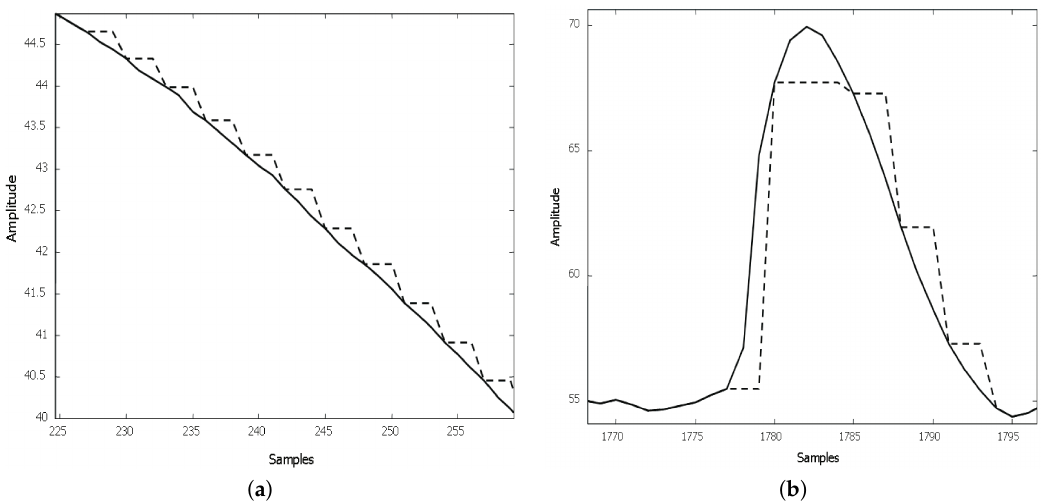
Figure 11. Problems for the wavelet approach. ( a ) case of too long sampling time with respect to the dynamics of the system; ( b ) signal which changes very